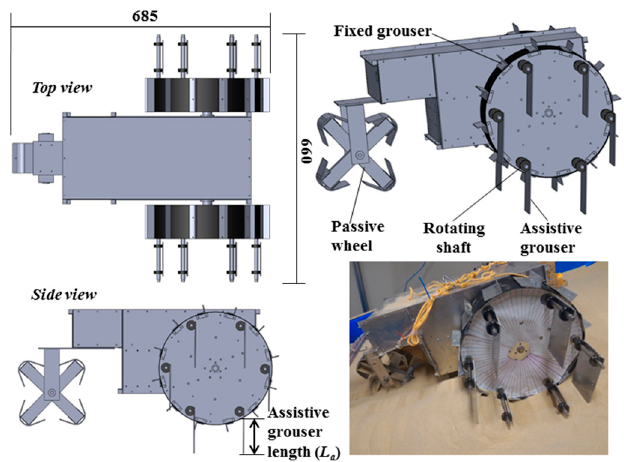
Figure 4. 3D CAD drawing and photo of wheeled grouser with attached assistive grouser mechanism.